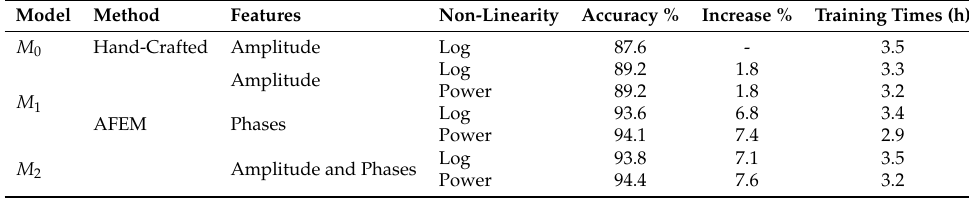
Table 7. The effect of different activation functions ( γ = − 1/7, Epoch =